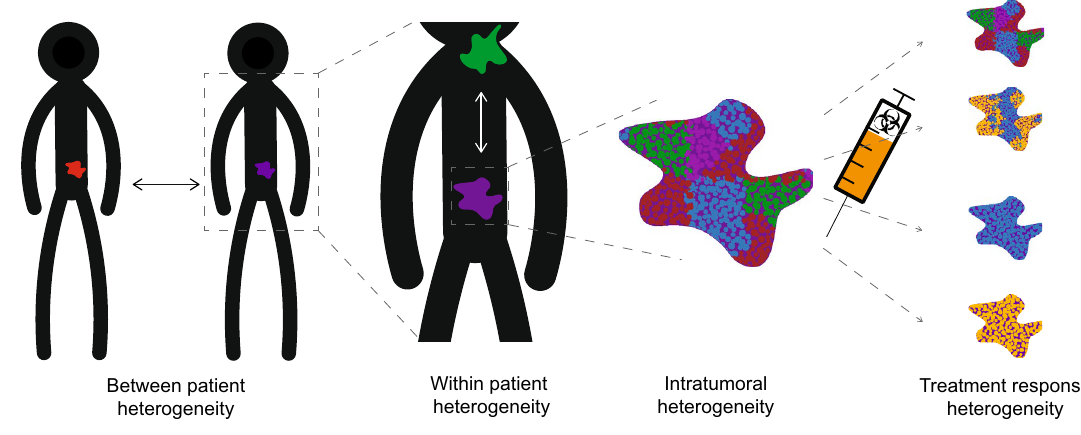
Figure 7. Schematic of a new dimension of tumor heterogeneity. Scientists and physicians have previously investigated heterogeneity between tumors in different patients, heterogeneity between different tumors in the same patient, and heterogeneity within the same tumor. Heterogeneity in tumor response to treatment also needs to be